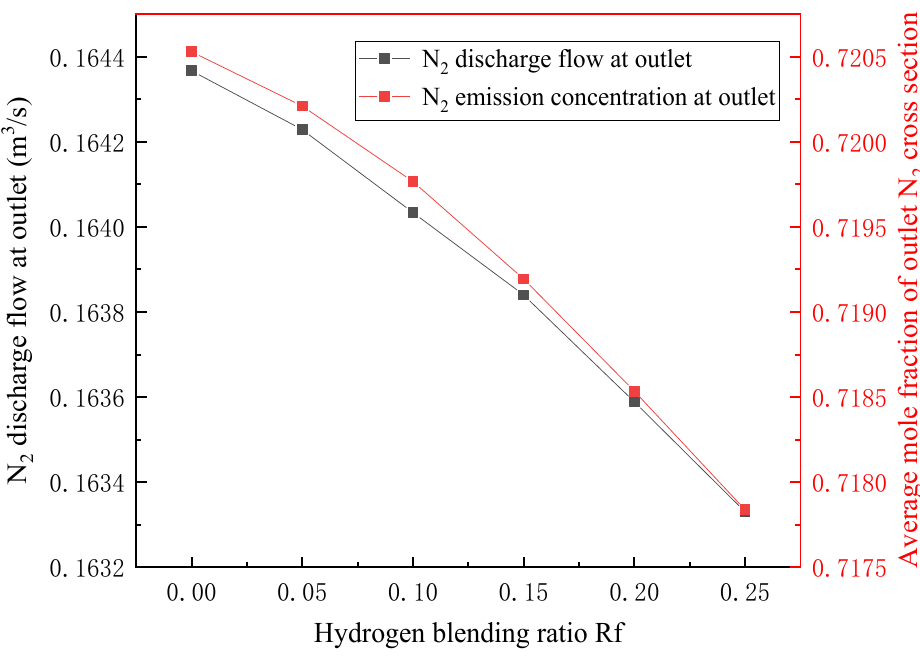
Figure 14. Emission concentration and discharge flow of N 2 at outlet.